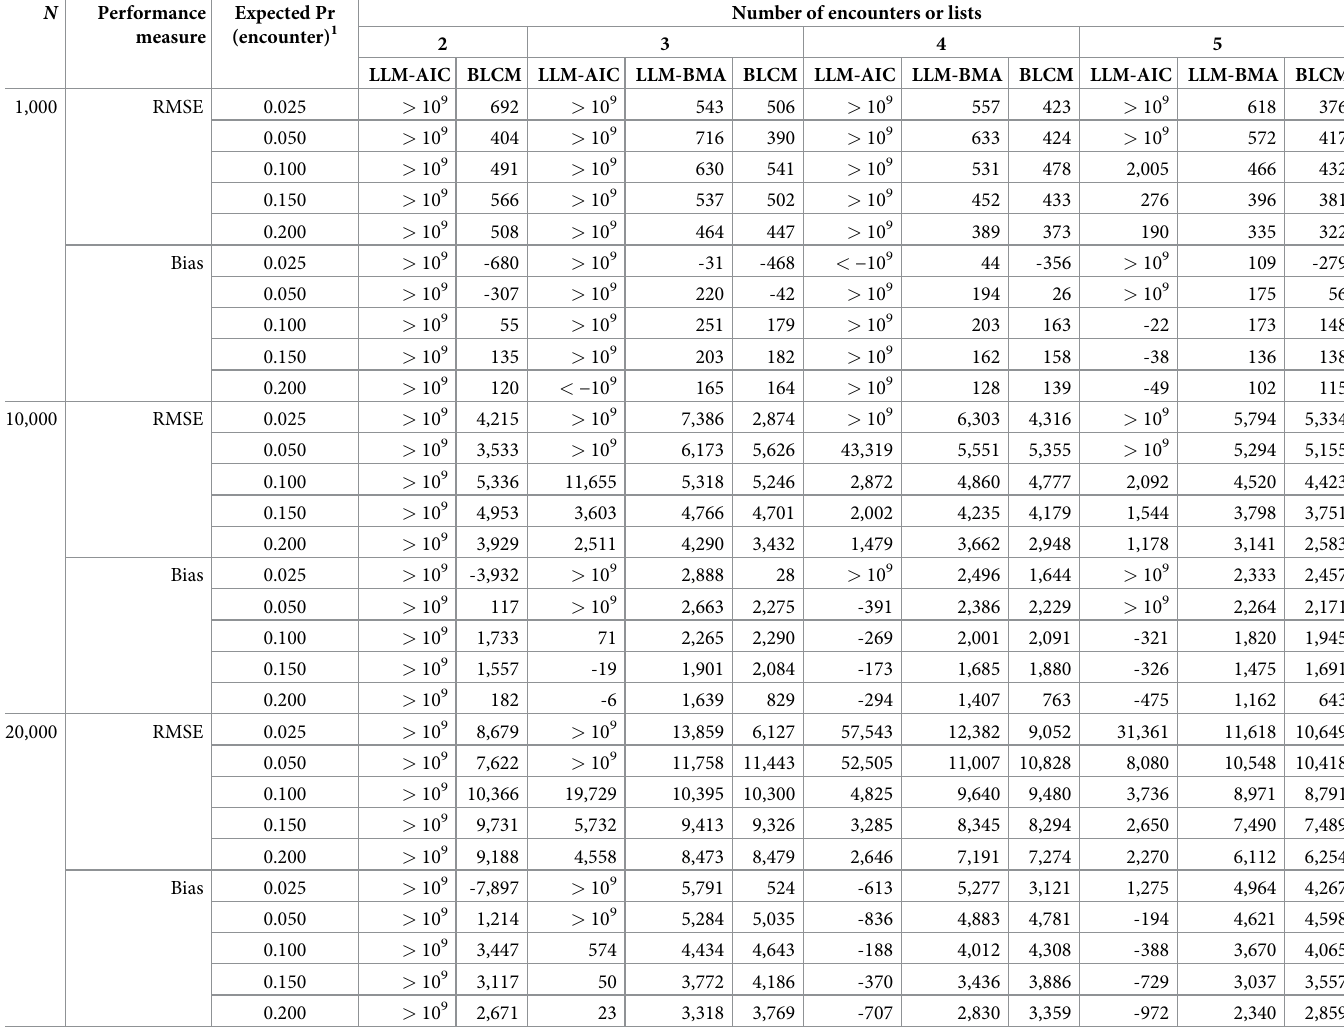
Table 2. Root mean-squared error (RMSE) and bias of estimators of the sizes N of simulated populations. N Performance measure